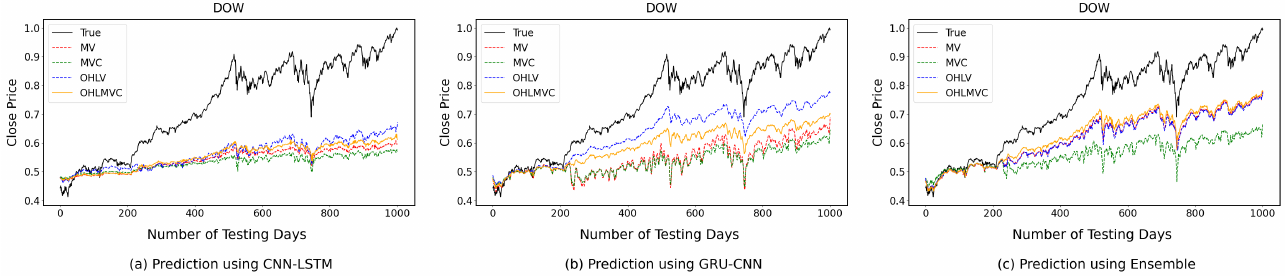
Figure 7. Comparison of true and predicted close prices of the DOW index between different input features for one-time-step prediction over the period from 1 January 2000 through 31 December 2019.